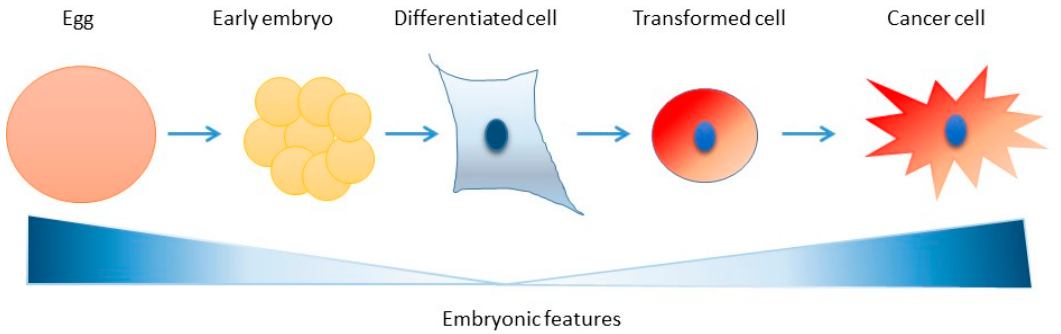
Figure 5. Awakening of embryonic features in cancer cells? Cartoon showing the degree of appearance of embryonic features in cells during the process of malignant transformation. Table 2. Features shared between early embryos, normal non-cancer and cancer cells. Unstructured chromatin features can be variable in cancer cells, with certain cancer cells having more structured chromatin than others do. N/C: nucleus to cytoplasm volume ratio. This can be variable in different cancer cells types and at different stages of malignant transformation.